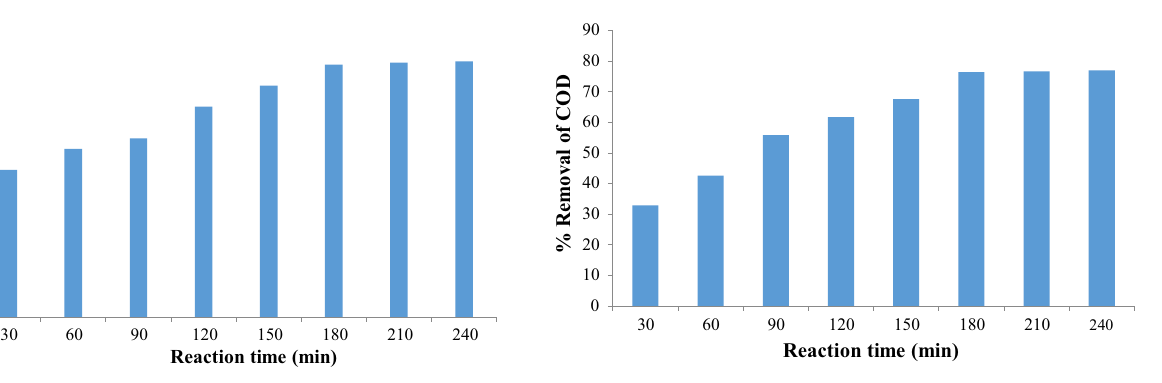
y = 0.186x - 0.0142 R² = 0.9528